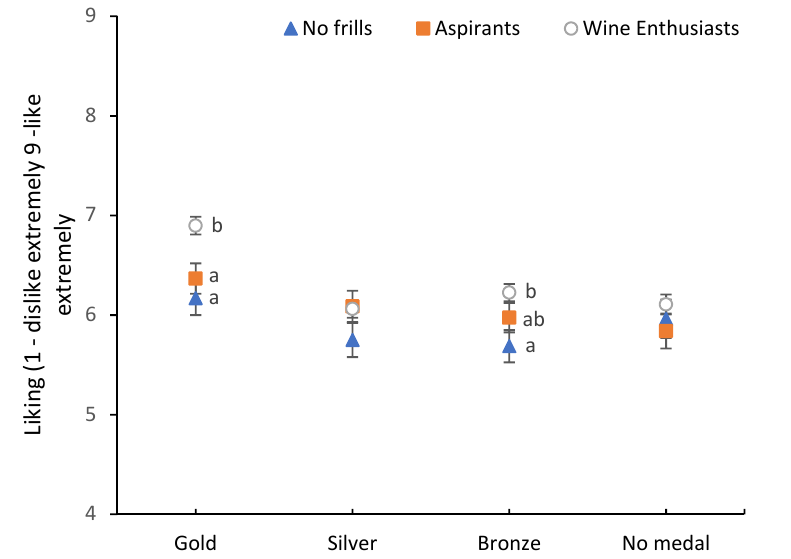
Figure 2. Hedonic responses of the fine wine segments (FWS) towards the four wine quality levels, pooled for context. Liking ratings were measured on a 9-point hedonic-scale, ranging 1 = dislike extremely to 9 = like extremely. Error bars indicate standard errors. Different lowercase letters indicate significant differences between FWS based on Fishers LSD post-hoc comparisons.